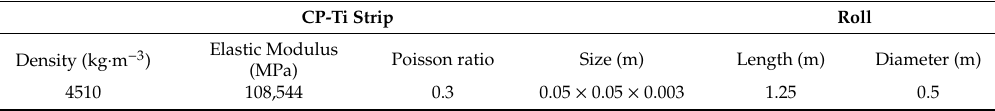
Table 1. Parameters of cold-rolling simulation.